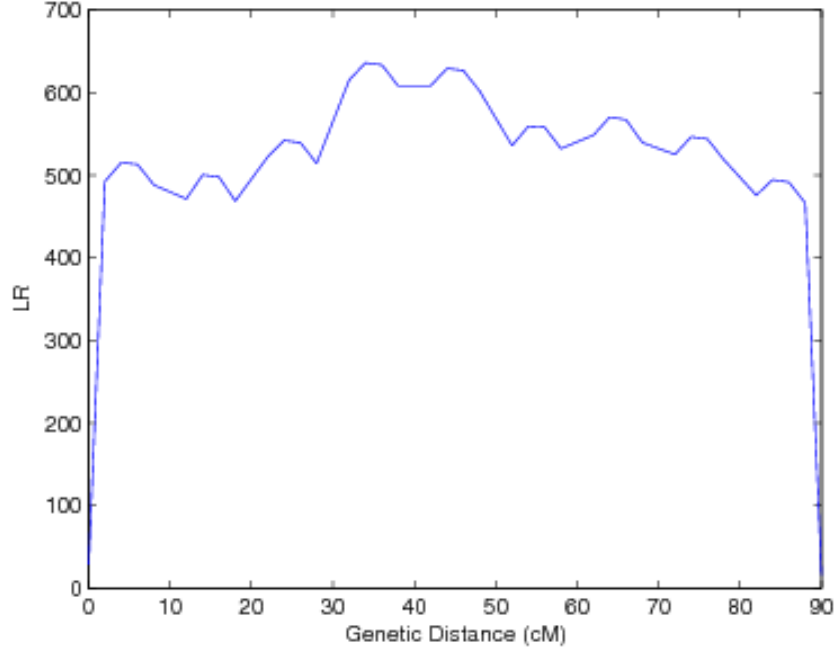
Figure 5. The profile of the log-likelihood ratio (LR) test statistics between the full (there is a QTL) and reduced (there is no QTL) models across a simulated linkage group. The covariance matrix was structured by the SAD(1)